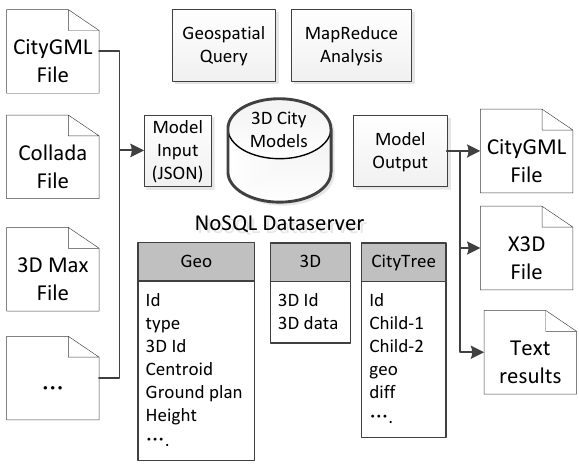
Figure 1. 3D city model management framework